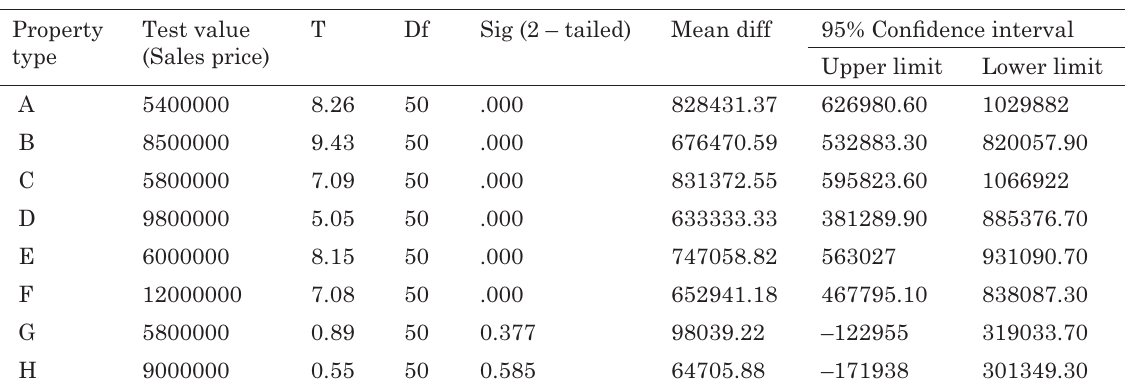
Table 6. One sample t –